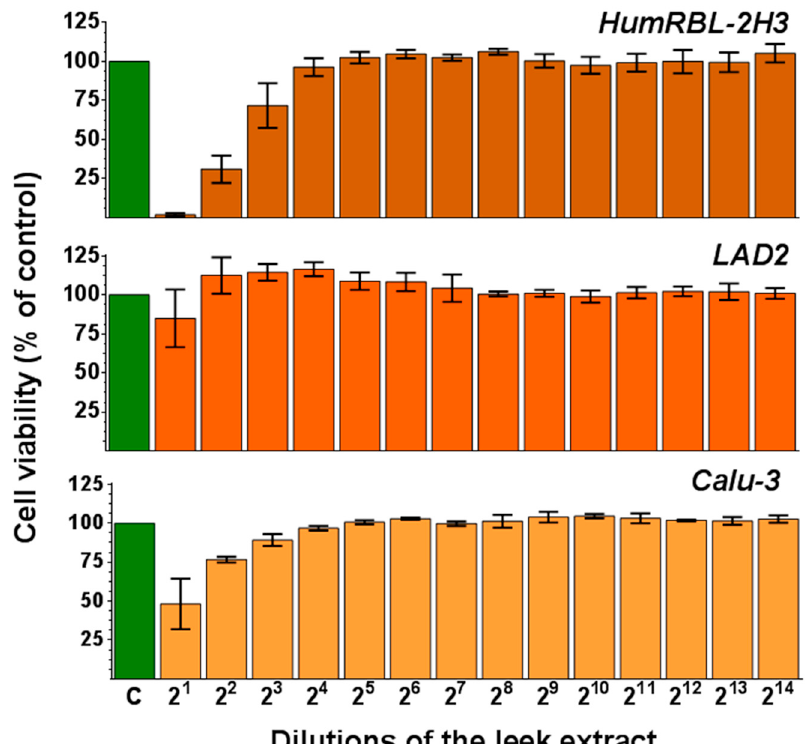
Figure 1. Cytotoxicity of methanolic LE at different concentrations on three cell lines: Humanized rat basophils (HumRBL-2H3), human mast cells (LAD2), and bronchial epithelial cells (Calu-3). The cell viability was assayed using the 3-(4,5-dimethylthiazol-2-yl)-2,5-diphenyltetrazolium bromide (MTT) method after 72 h of treatment. DMSO was used as positive control. Data are expressed as a percentage (%) of control (C) and shown as the mean ± SEM of three independent experiments.